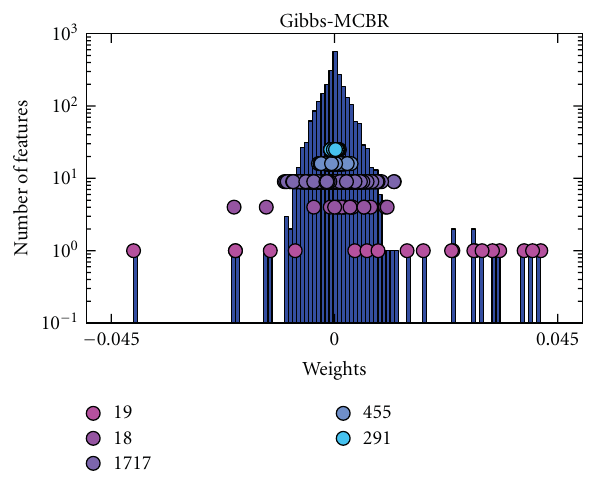
Figure 5: Intersubject analysis . Histogram of the weights found by Gibbs-MCBR and corresponding z values (each color of dots represents a di ff erent class), for the intersubject analyzes. We can see that Gibbs-MCBR creates clusters of informative and noninformative voxels and that the di ff erent classes are regularized di ff erently, according to the relevance of the features in each of